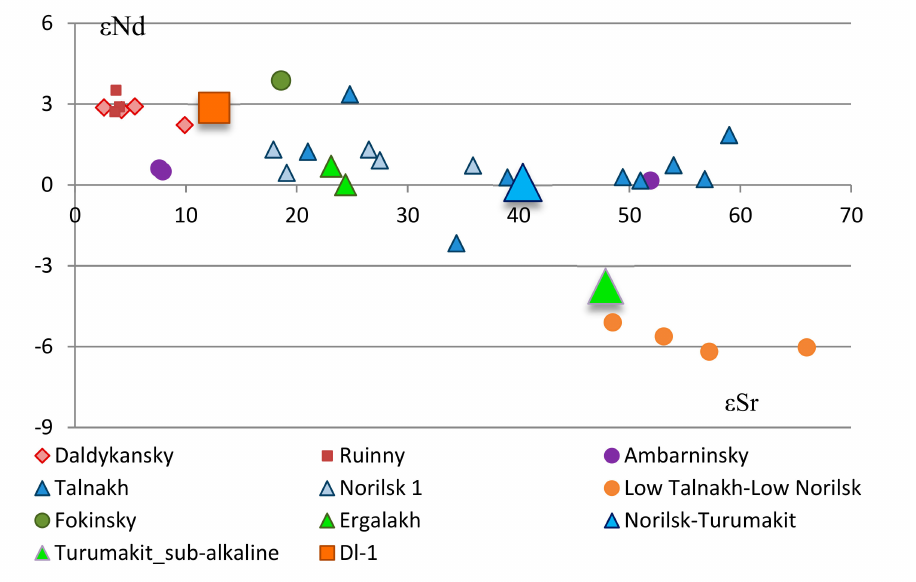
Figure 17. ε Nd- ε Sr diagram for intrusive rocks of the Norilsk region (data are from [16] and unpublished authors’ data, large symbols, studied Turumakit samples: BT-6 / 169.2; Norilsk-Turumakit, BT-1 / 114.6; supposed Ergalakh,